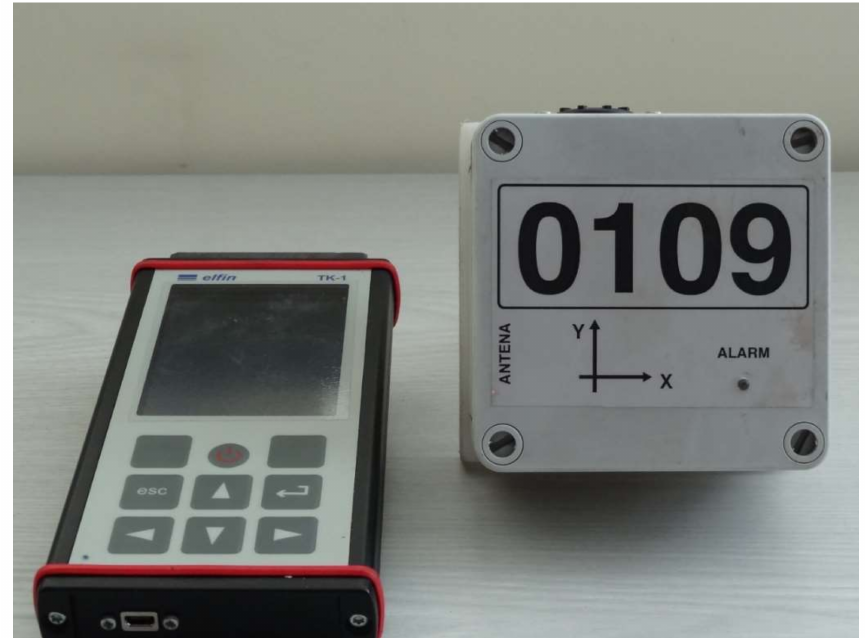
Figure 3. Measurement equipment (the TK communication terminal + the CNS-2 inclinometer) [20]. Figure 4 shows a schematic representation of the sensor operation. The sensor assumes positive or negative values depending on the direction of its deflection. As a rule, the sensor axes are oriented in relation to the axis of the excavation. The floor area and the initial slope of the rockbolt’s rod are irrelevant as the measurement is relative.